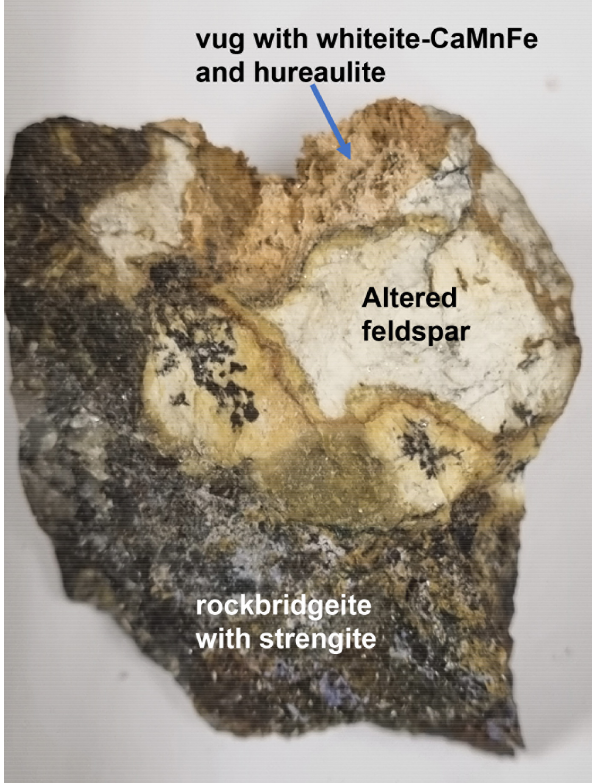
Figure 1. Specimen Hag107, showing vug containing whiteite- (CaMnFe)